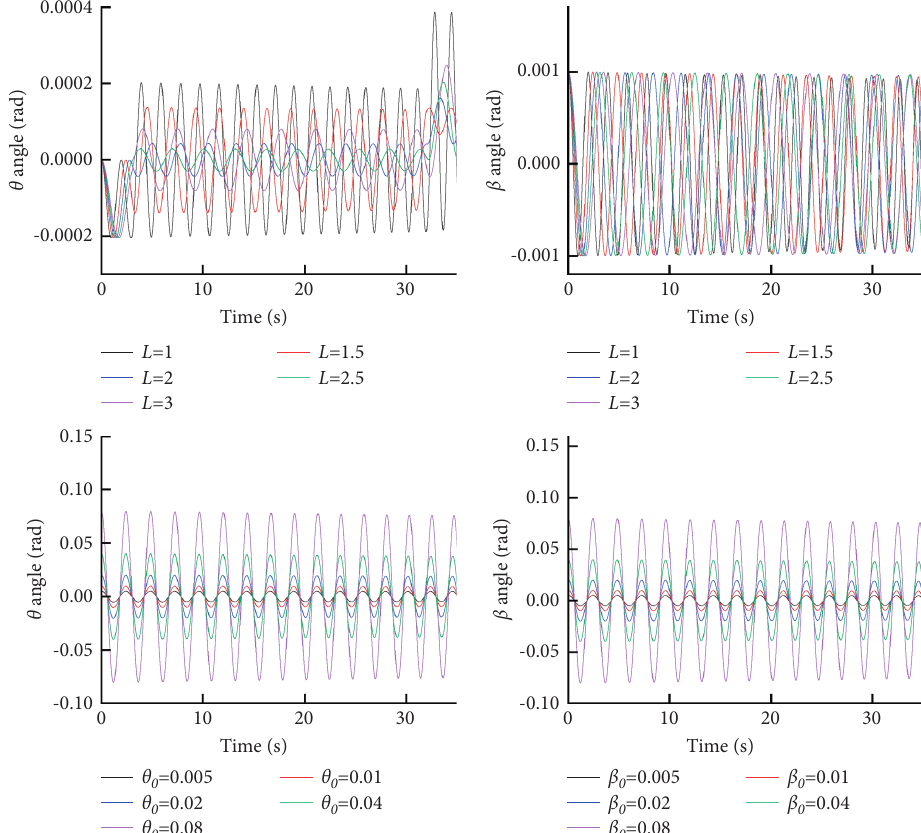
Figure 7: Response of L , θ